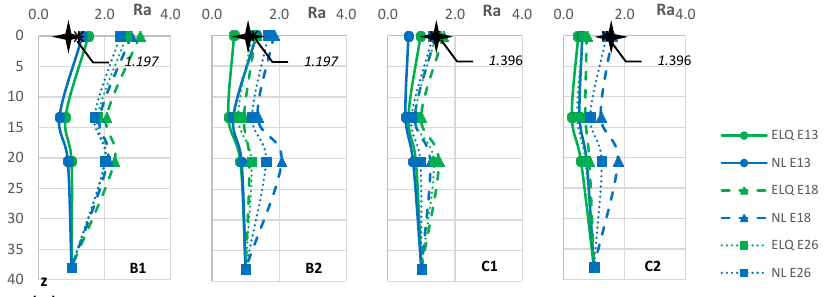
Figure 19. Comparison between amplification ratios in SSI alignment for the two different constitutive models (equivalent visco-linear elastic — ELQ vs. nonlinear — NL).